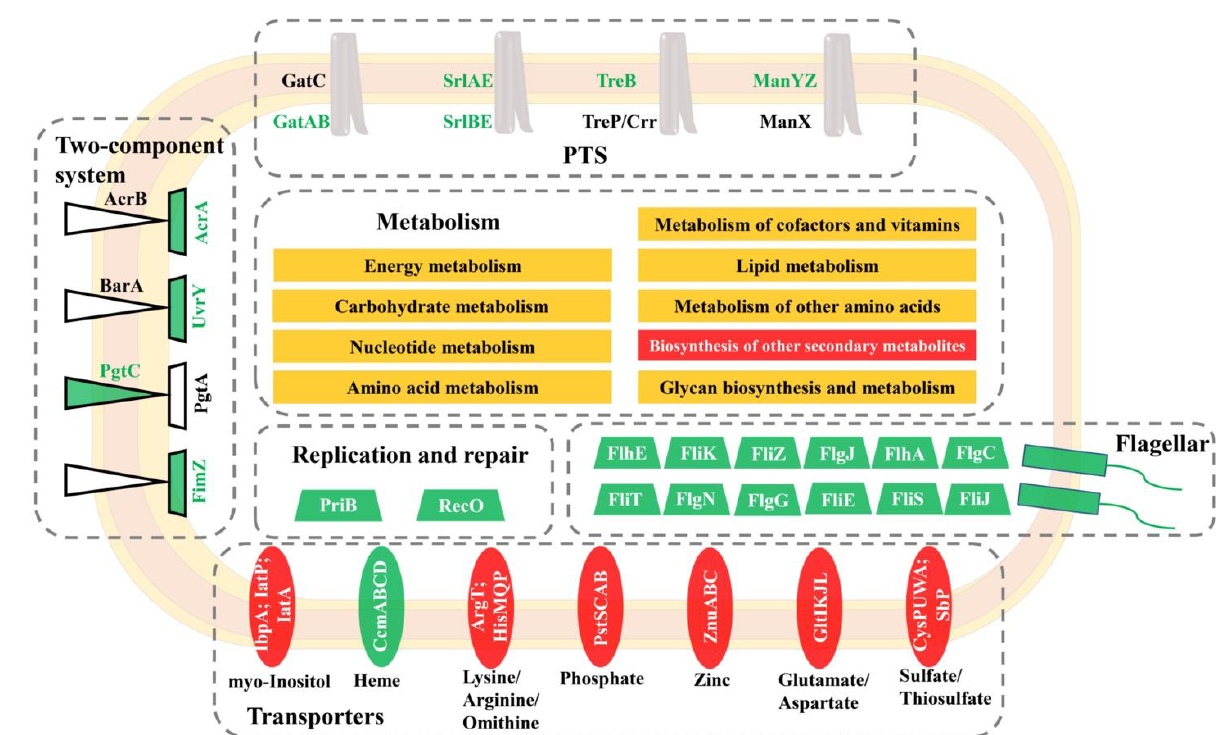
Figure 5. A proposed model for the adaptation of S . Enteritidis to 130 ppm sodium hypochlorite. Red indicates that a certain pathway contained proteins with increased abundance, green indicates that a certain pathway contained proteins with decreased abundance, and yellow indicates that a certain pathway contained proteins with increased and decreased abundance.